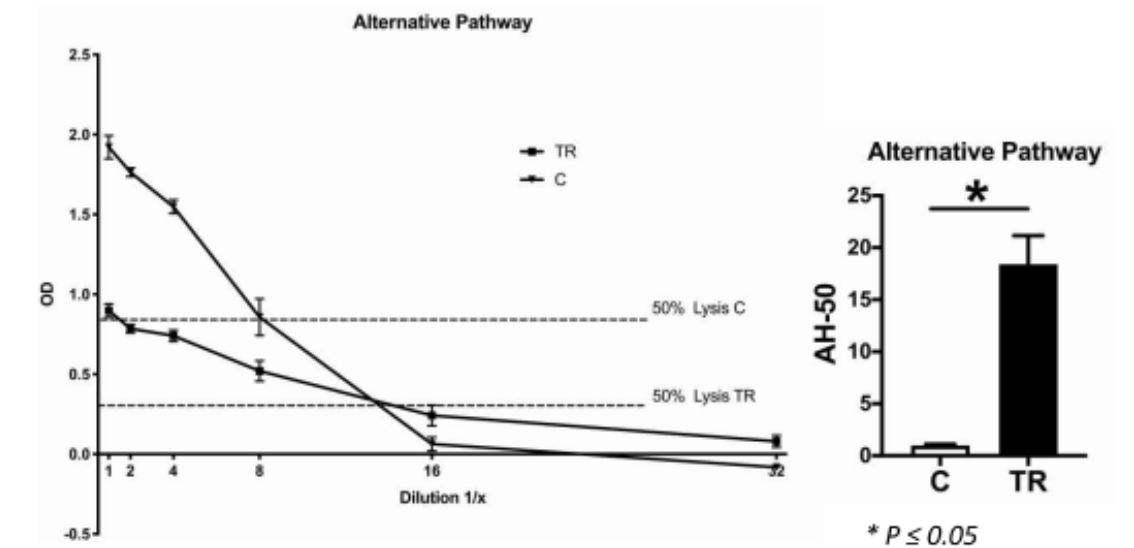
Figure 8. Hemolytic assay for the detection of complement alternative pathway function. The optical density of the serum samples of both the control (C) and tooth resorption (TR) groups were plotted against the dilution factor. The curves show the control (4 cats) and TR groups (10 cats) with different levels of complement function. In both groups, 50% lysis occurred between serum dilutions 1:8 and 1:16. Nevertheless, there was a significant difference in the serum complement concentration between the two groups, being significantly higher in the TR group than in the control group ( p ≤ 0.05).